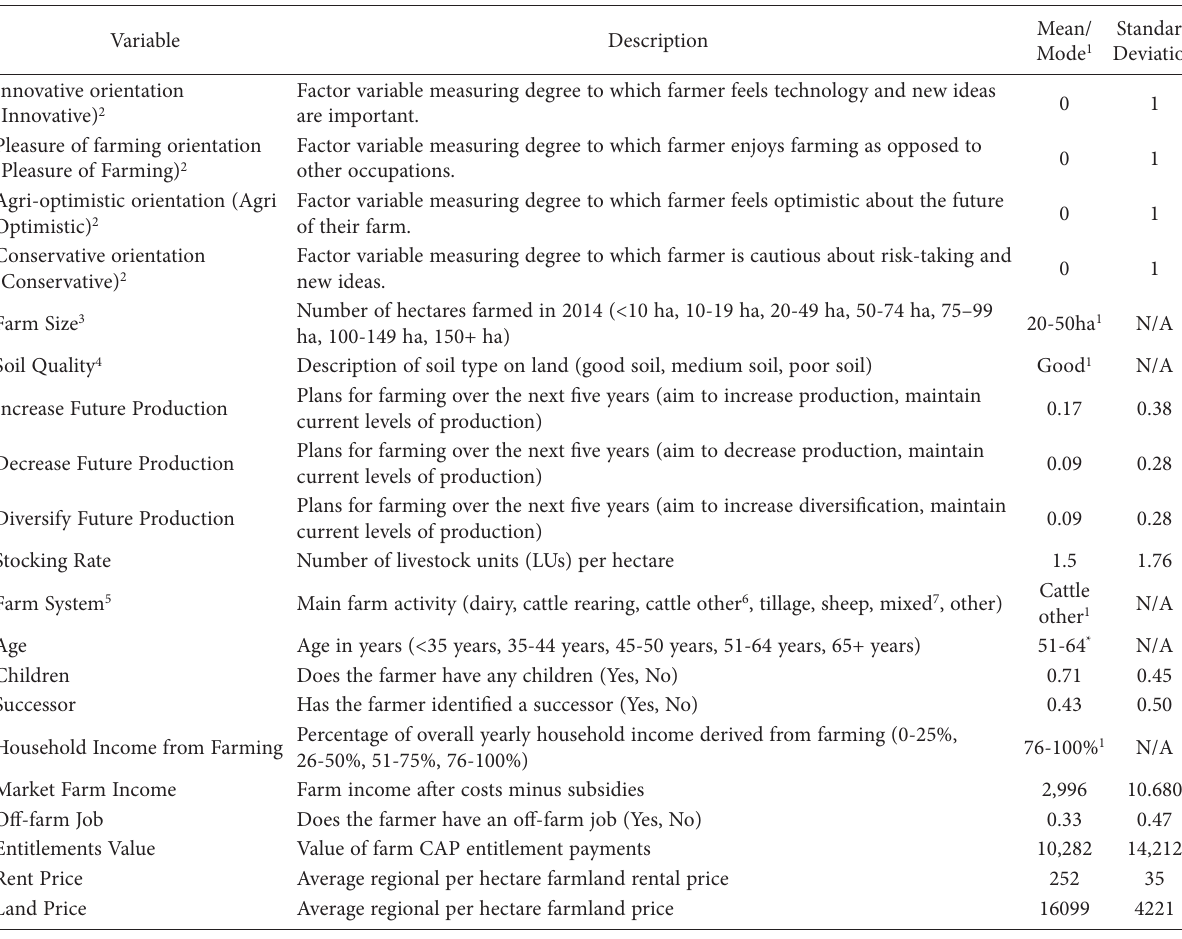
Table 4. Independent variables of land mobility